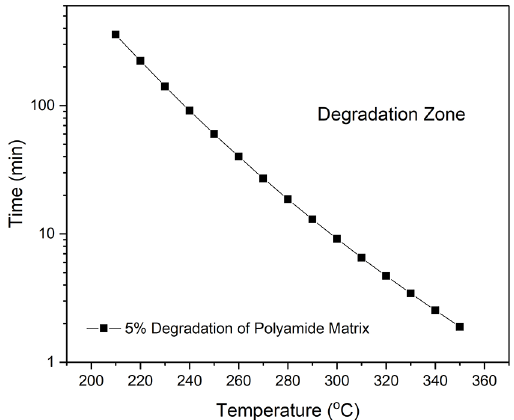
Figure 3. Prediction of the time as a function of temperature for 5% degradation degree of the PA matrix. (Bibliographic Source: